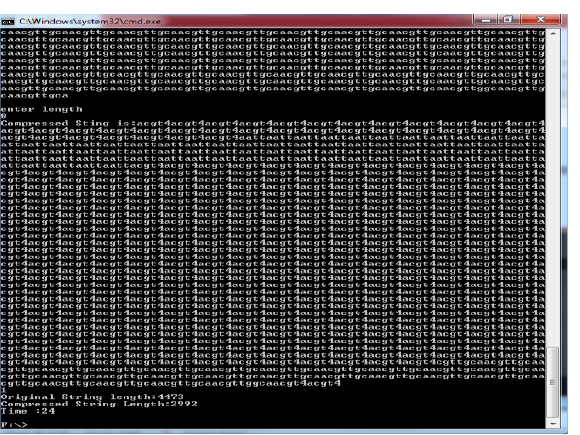
Figure 2 Compression of DNA sequences